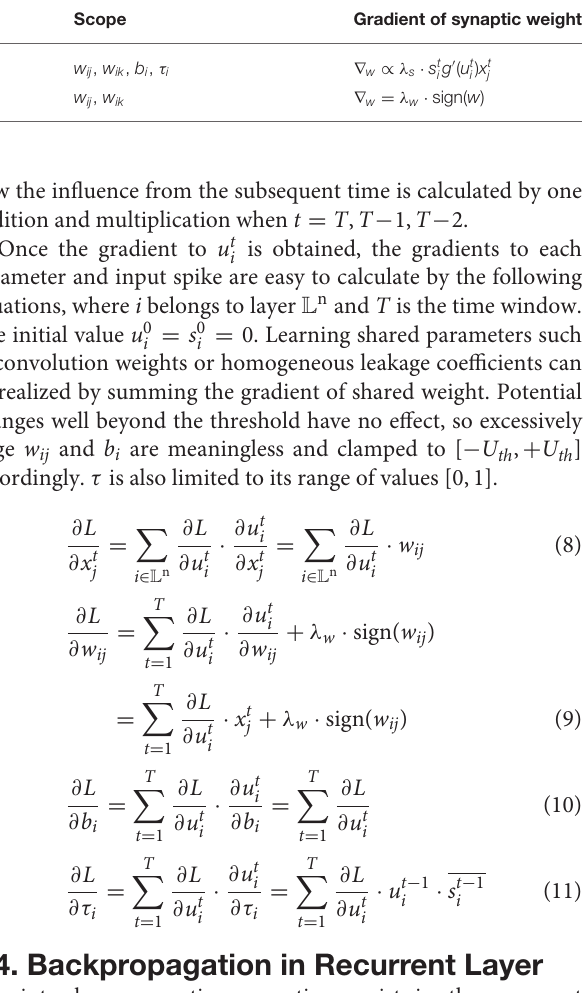
TABLE 1 | Comparison between spiking and synaptic regularization.